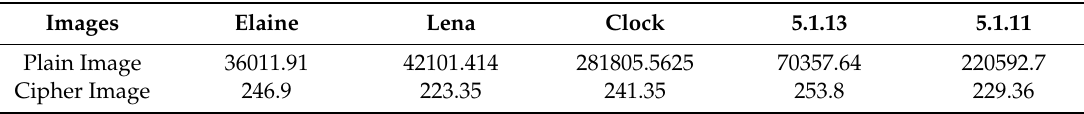
Table 1. Chi-square values of sample